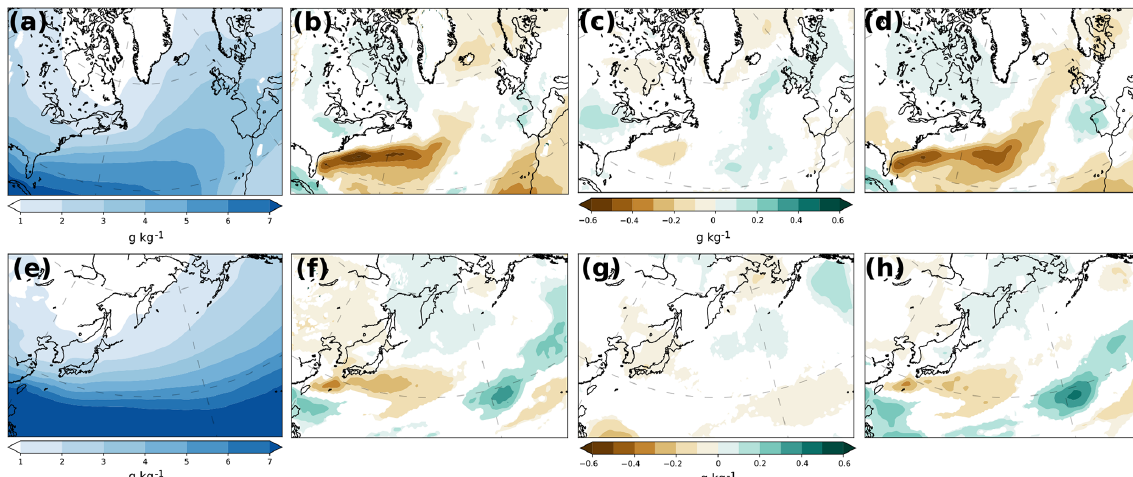
Figure 9. (a) Climatological specific humidity at 850hPa (shading, gkg − 1 ) for the North Atlantic for CNTL. (b) Statistically significant ( > 95%) difference of climatological specific humidity between SMTHG and CNTL (SMTHG–CNTL). (c, d) As panel (b) but separated for specific humidity within (c) and outside (d) a radius of 750km around a cyclone centre. (e–h) As panels (a) – (d) but for the North Pacific.